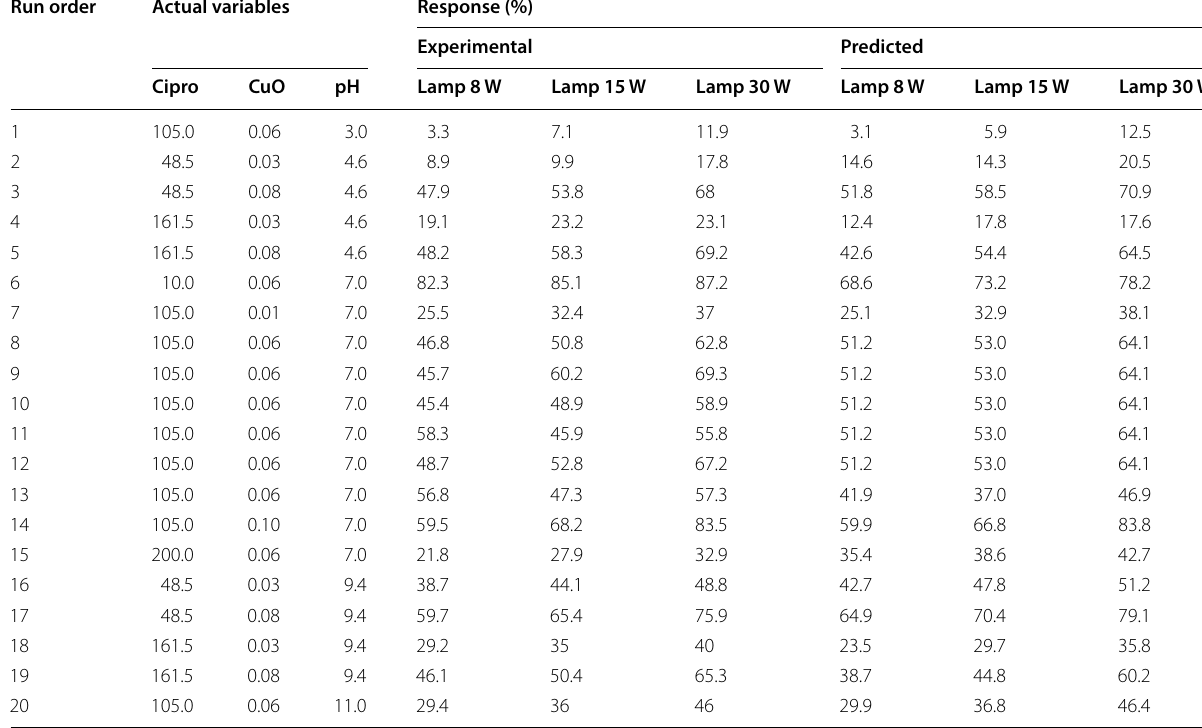
Table 2 Central composite design (CCD) and observed responses Run